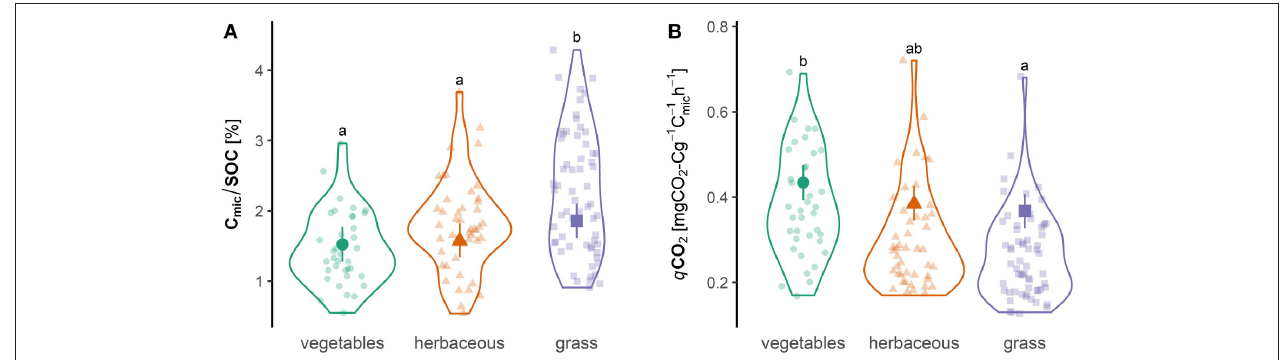
FIGURE 4 | Violin plots showing probability density of the raw data of (A) Microbial quotient C mic /SOC and (B) the metabolic quotient q CO 2 . Colors correspond to the different garden habitat types with the following observation numbers: Annual vegetables ( N = 37), perennial herbaceous ( N = 46), and perennial grass ( N = 62). Bold points are mean values of the simulated Bayesian inference posterior distribution taking into account the random effect of garden identity with the 95% credible intervals as lines. Letters are least square means from linear mixed effect models (cf. Table S11) with a significance level alpha =